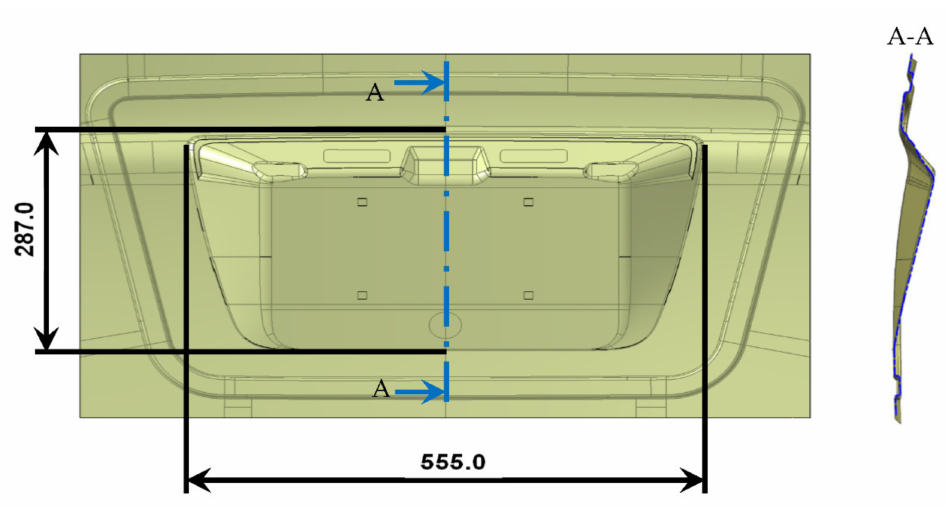
Figure 2. Design of the part formed by